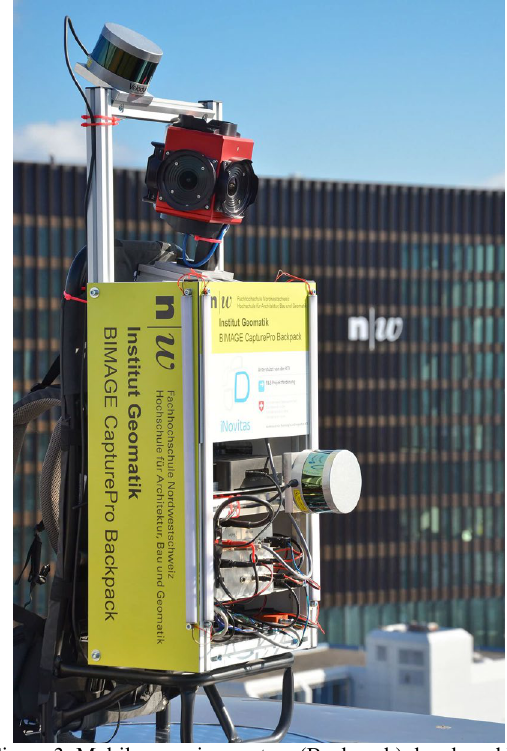
Figure 3. Mobile mapping system (Backpack) developed by FHNW, Institute of Geomatics (Blaser et al 2018) New image-based mobile reality capturing techniques